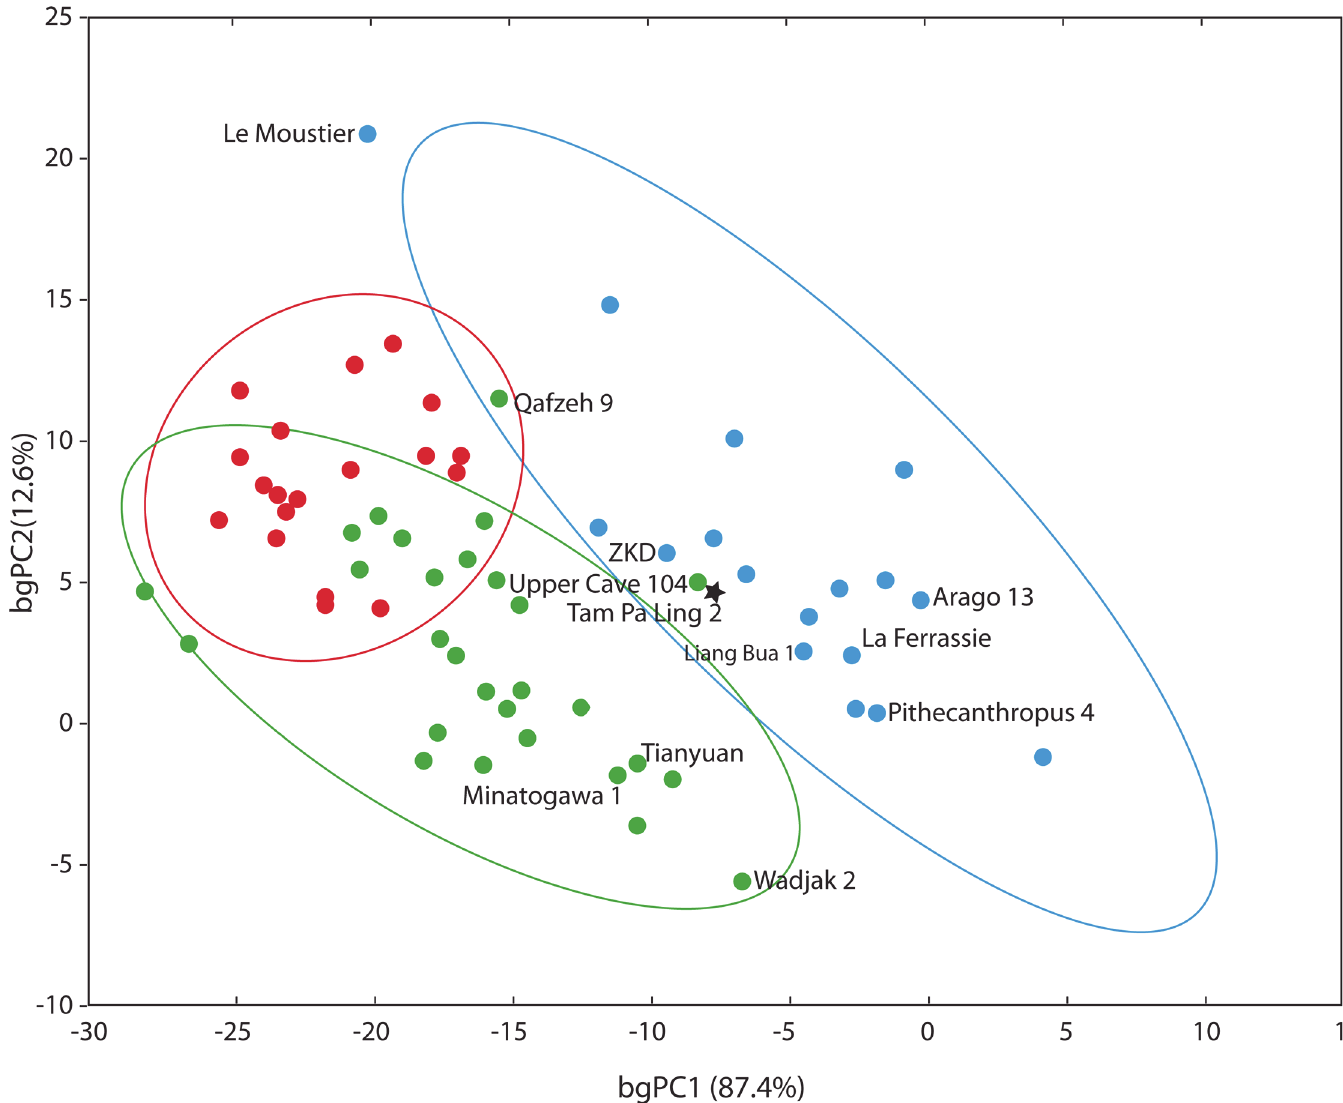
Fig 3. Between group principal component analysis (bgPCA). This plots the first two eigenvectors that separates three a priori defined groups: blue circles: Middle and Late Pleistocene archaic humans; green circles: Late Pleistocene early modern humans: red circles: Holocene humans. Fossils of particular interest are specified by name. Specimens included in the analysis are listed in S5